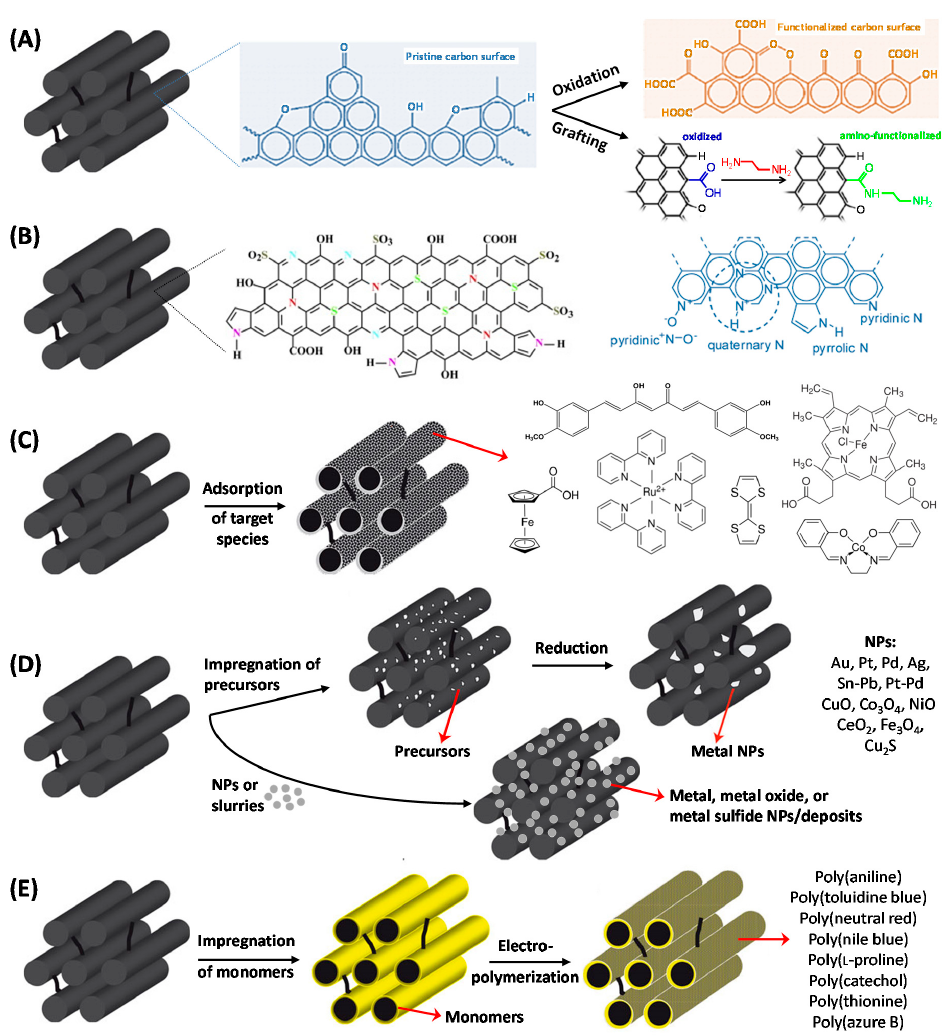
Figure 6. Illustration of the various ways to functionalizing OMC used in electrochemical sensors: ( A ) surface oxidation and grafting; ( B ) bulk N,S-doping; ( C ) adsorption of mediators ( D ) binding of metal nanoparticles or deposition of metal, metal oxide or metal sulfide; ( E ) electropolymerization.